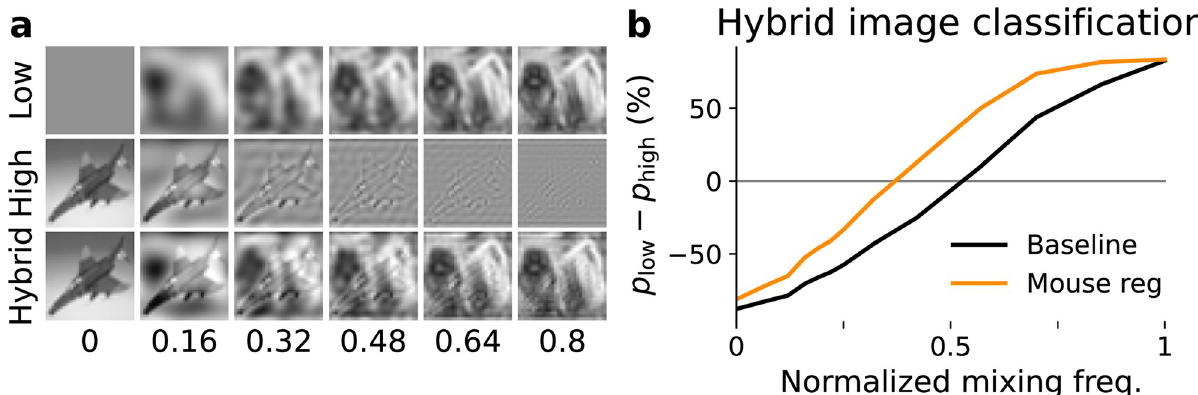
Fig 3. Probing frequency sensitivity of mouse regularized model using hybrid images. (a) Examples of hybrid images at different mixing frequencies. Hybrid images are constructed by mixing the low-frequency component of one image and the high-frequency component of another, while the two seed images belong to different categories. The range of mixing frequency’s values are normalized by the Nyquist frequency. (b) Model predictions on hybrid images at different mixing frequencies. As more low-frequencies from one image are included, the probability that a network reports its label p low increases. The reversal frequency f rev where p low = p high is smaller for the mouse regularized model (‘neural’) than for the baseline model (‘base’).